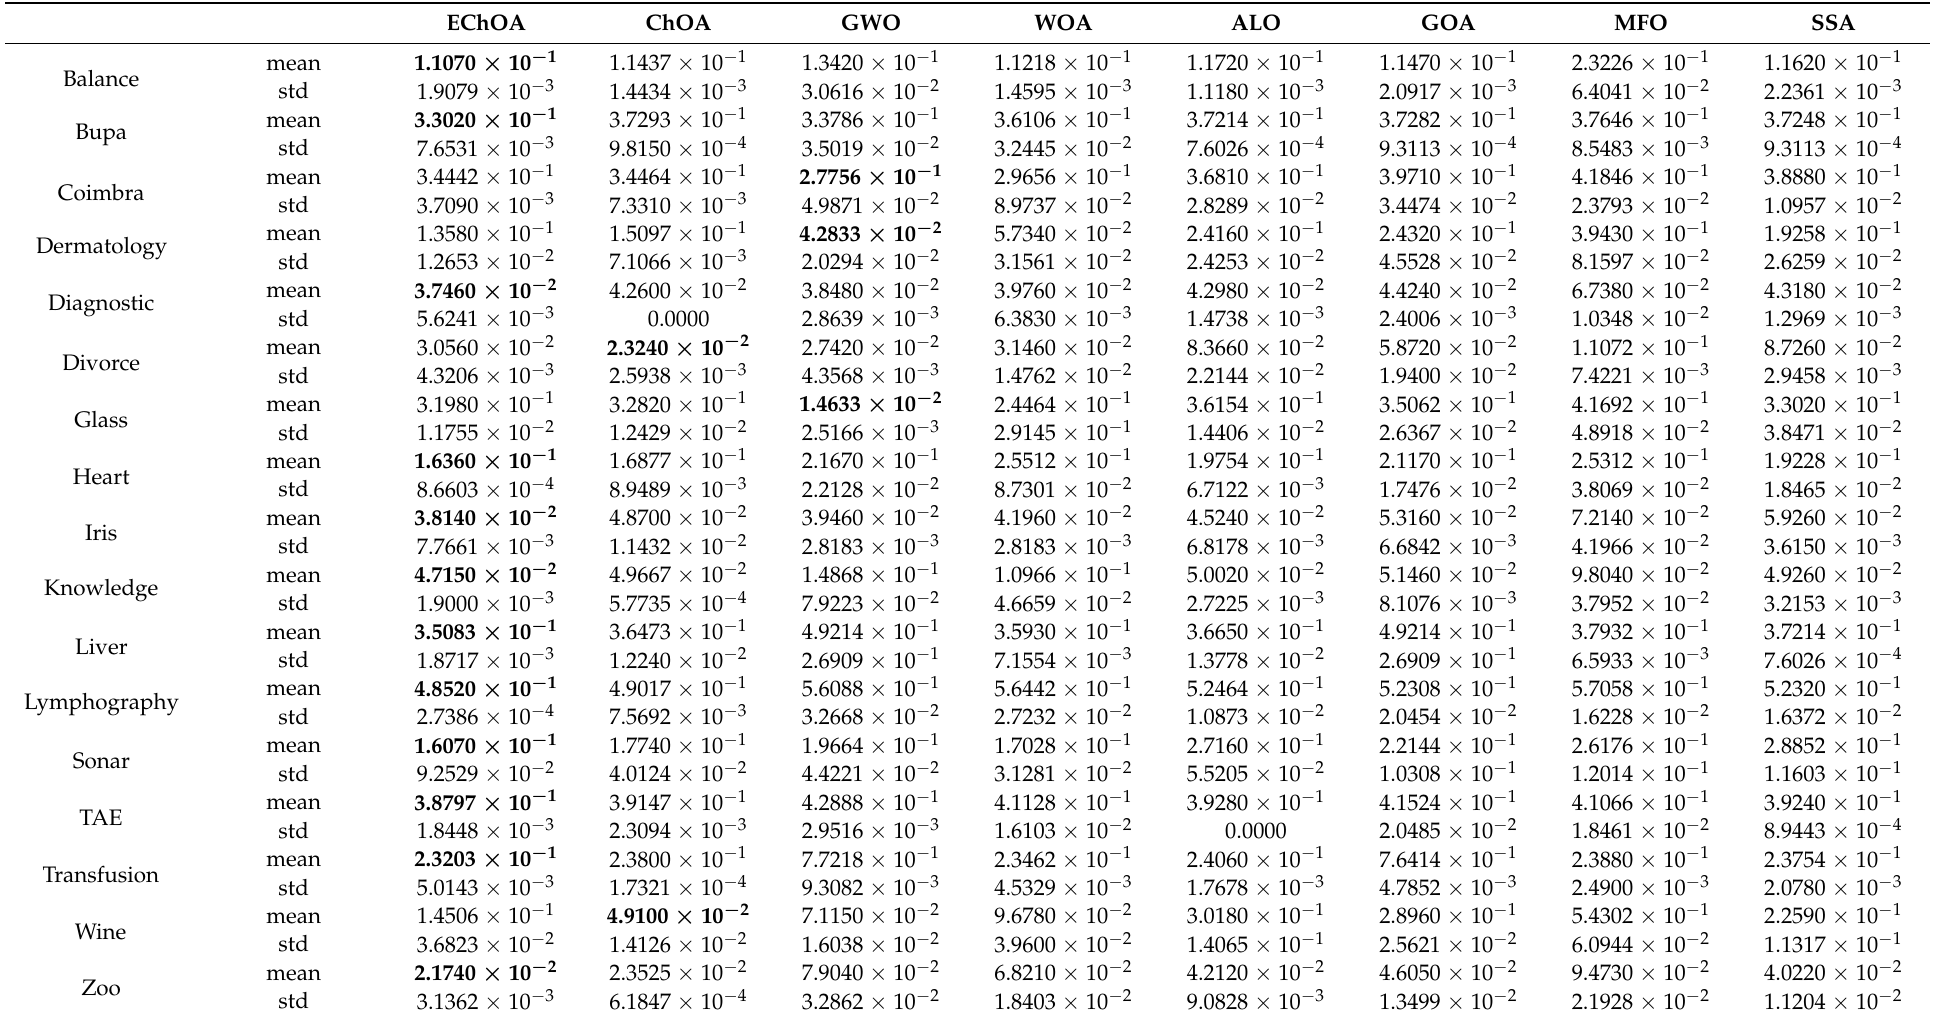
Table 5. Mean and standard deviation of fitness values for all data sets with applying feature